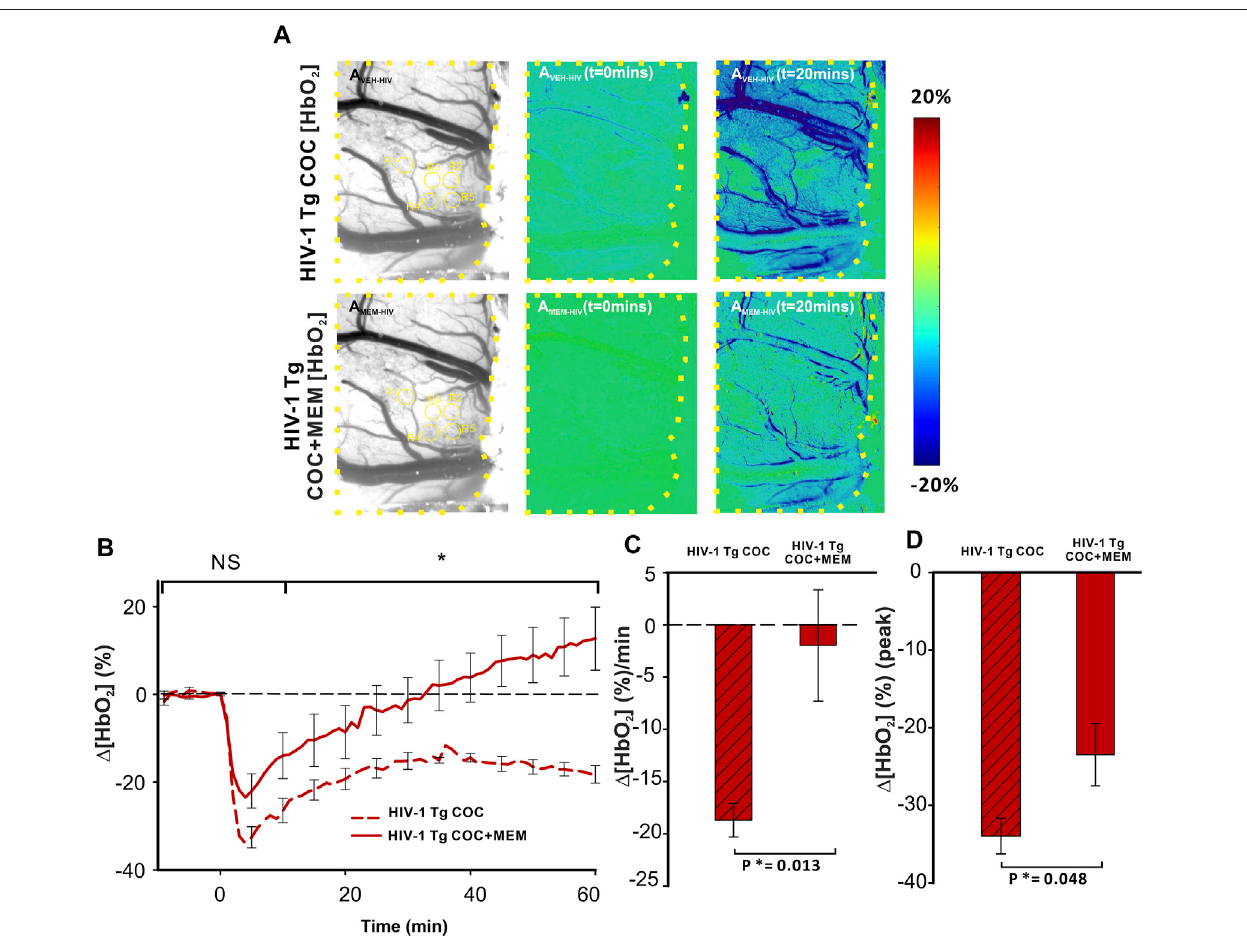
FIGURE 8 | Cocaine-induced decrease in oxygenated hemoglobin improved with memantine in HIV-1 Tg rats. (A) Ratio imaging of HbO 2 in the PFC of HIV-1 Tg rats following exposure to cocaine after pretreatment with either vehicle (upper panel) or memantine (lower panel). Areas encompassed within the dashed yellow lines represent the brain region of interest. ROIs used for quanti fi cation are in yellow circles. (B) Memantine administration prior to cocaine improved the cocaine-induced reduction in Δ [HbO 2 ] returning to baseline but remained decreased in the PFC of animals with vehicle pretreatment. (C,D) Total cocaine-induced reduction in Δ